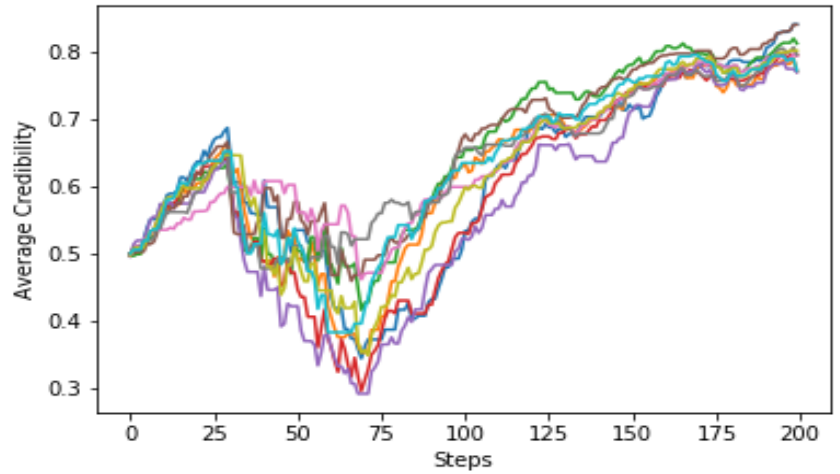
Figure 11. Change in average credibility for each information sharing agent when five agents change their performances; the change process is as defined in